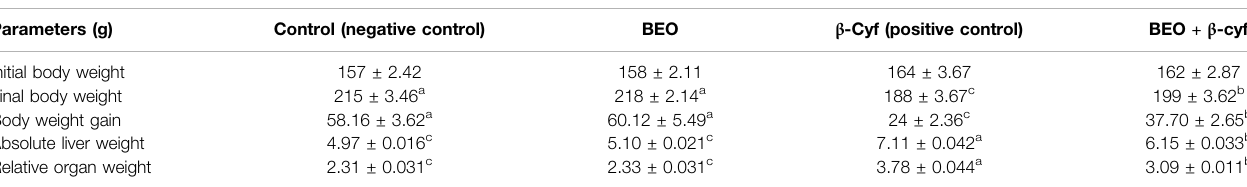
TABLE 4 | Liver and body weights in different